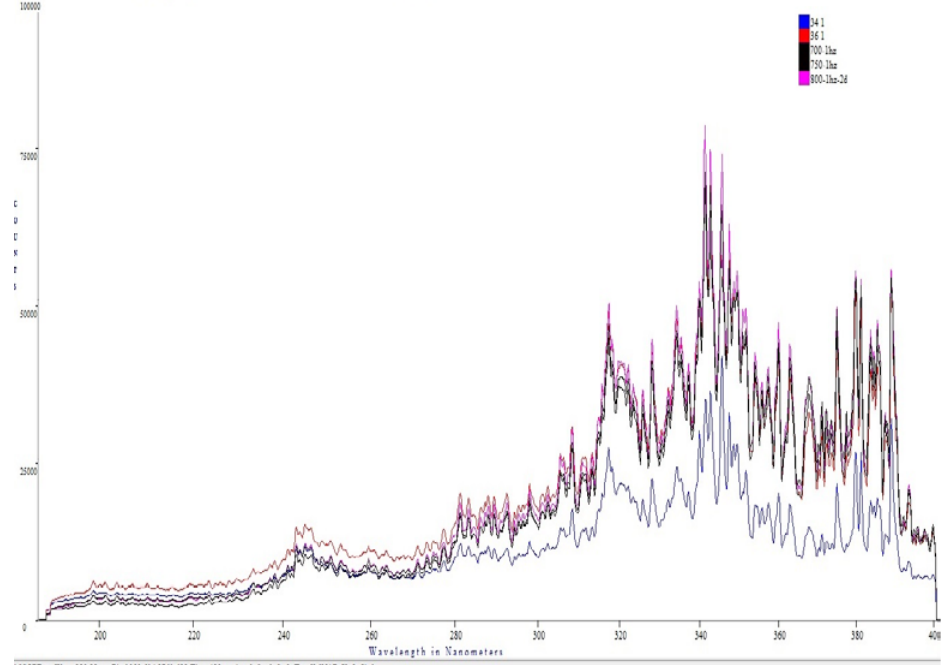
Fig.7: The emission spectra of laser induced holmium plasma with different laser energies and (1 Hz) repetition rate.